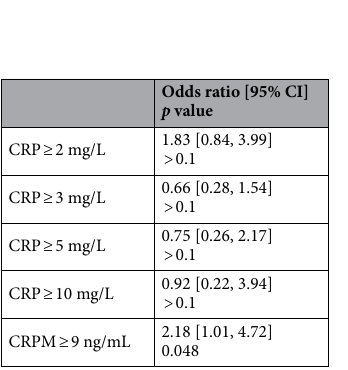
Table 5. The odd ratio for radiographic progression (2-year KL change ≥ 2) at elevated biomarker levels, after adjustment for baseline BMI, gender, age, JSW, KL and VAS pain, in OA-CC